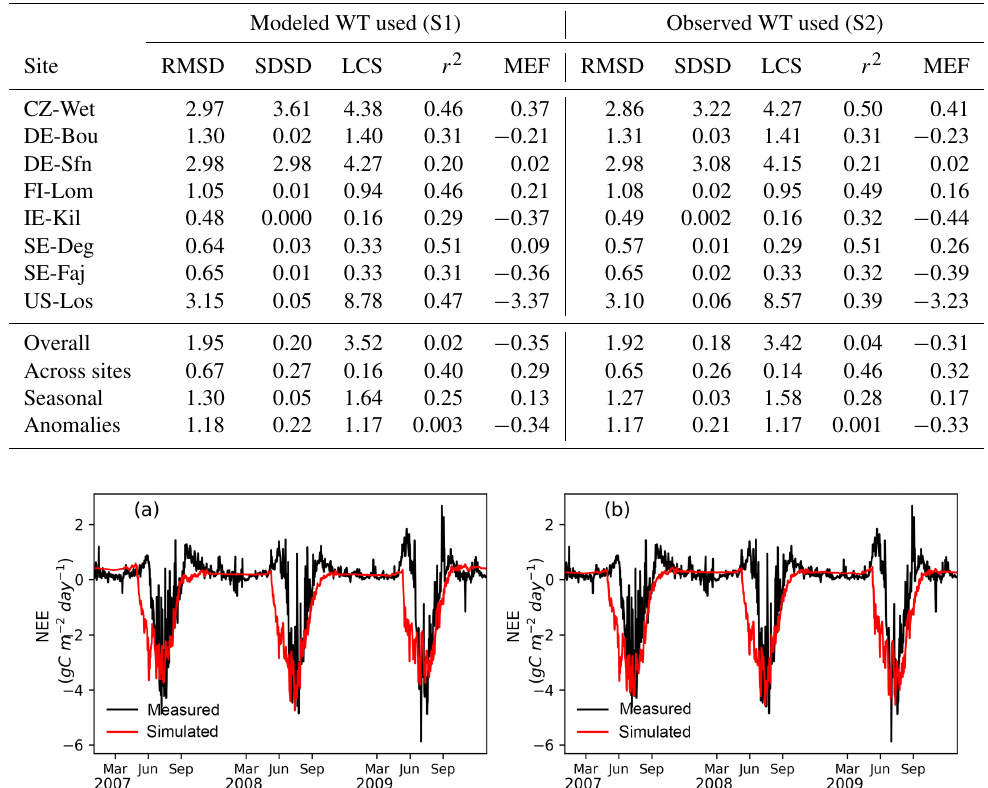
Figure 6. Observed and simulated daily mean NEE at the FI-Lom fen site in (a) S1 (simulated WT was used in the carbon module) and (b) S2 (modeled water table was assimilated to WT obs and was used in the carbon module).